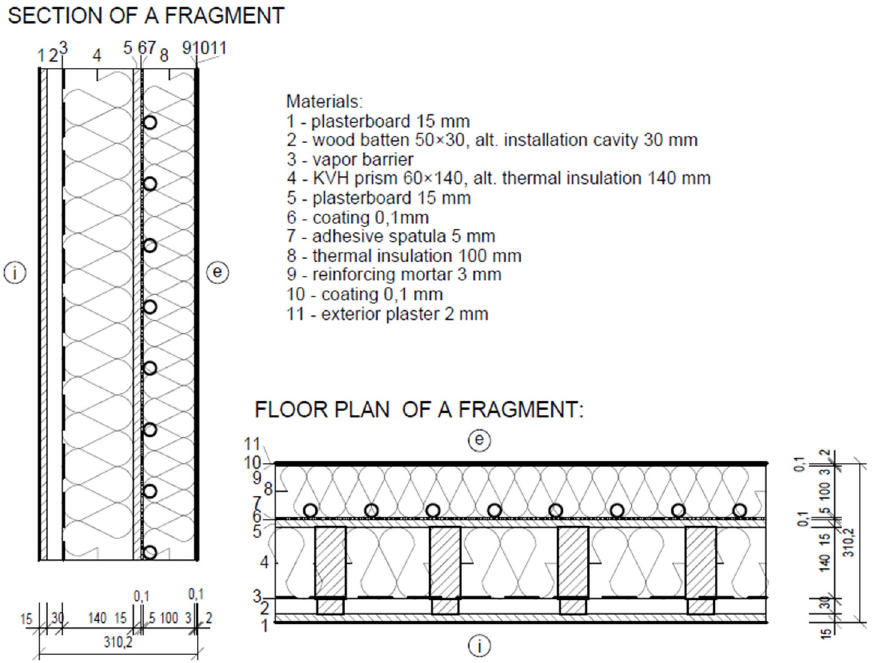
Figure 29. Details of test cell wall fragments. e—exterior, and i—interior.